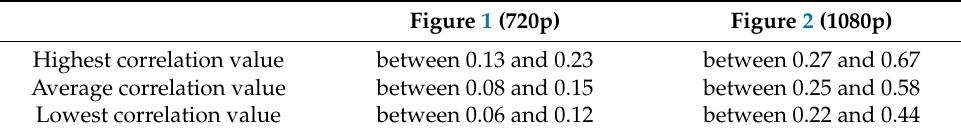
Table 2. Overview of the highest, average and lowest correlation values for both resolutions.